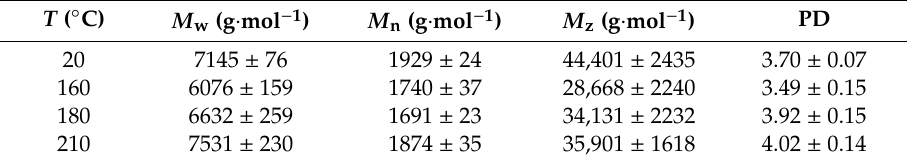
Table 4. Results of macromolecular characteristics of lignins from teak wood. Data represent mean ± SD.